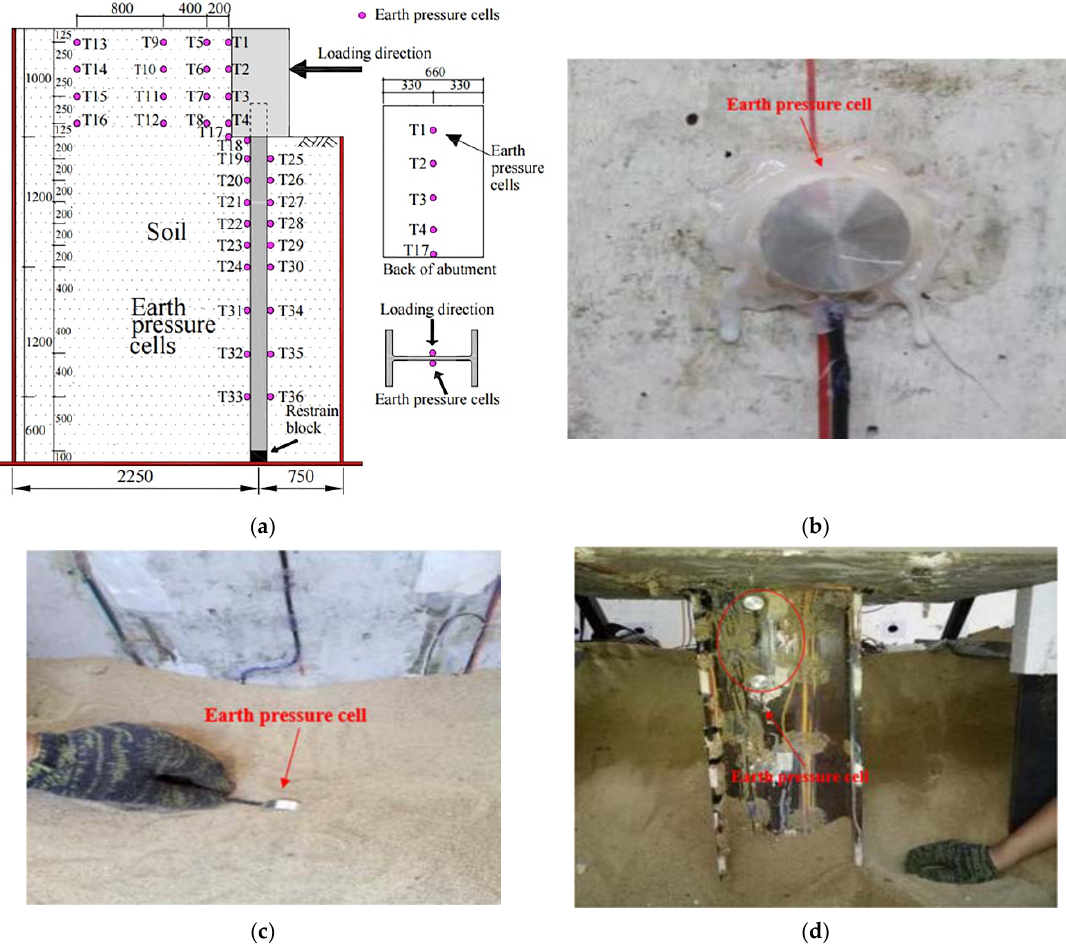
Figure 5. Layout of earth pressure cells (unit: mm). ( a ) Layout of earth pressure cells. ( b ) Cell on the abutment. ( c ) Cell behind the abutment. ( d ) Cell on the pile.